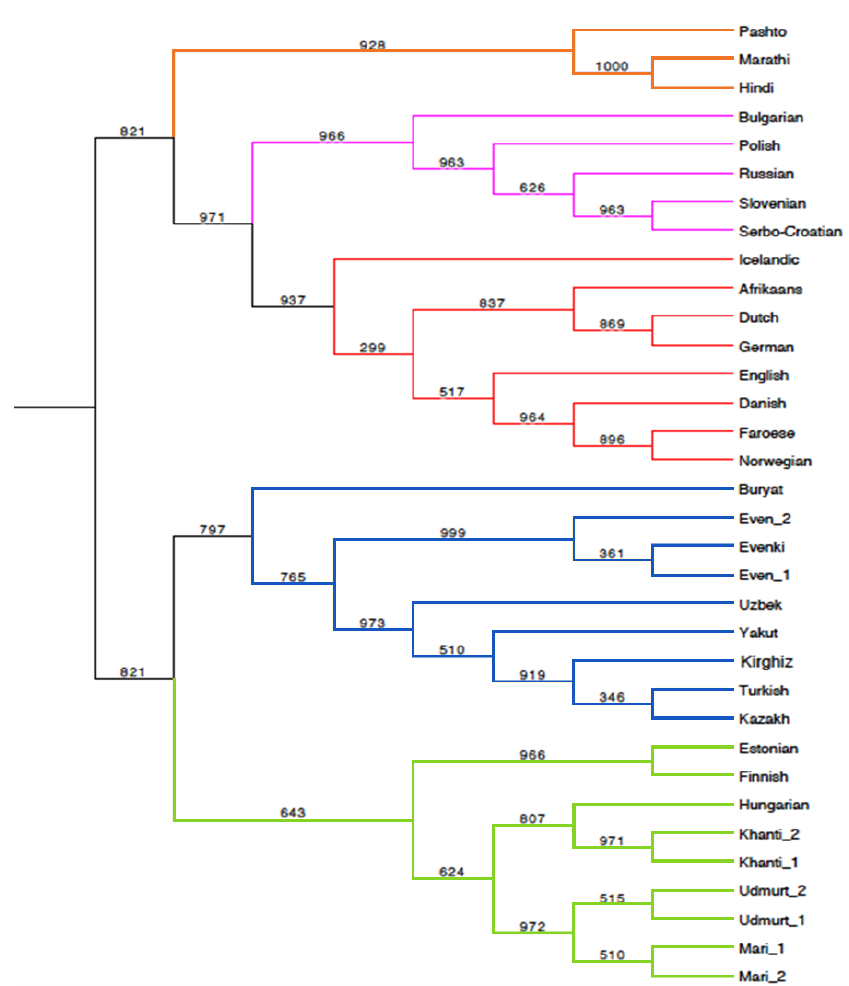
Figure 1. Principal Coordinate Analysis (PCoA) from the syntactic distances in 34 Eurasian populations. Language groups coded as follow: Finno-Ugric ( green ), Altaic ( blue ), Indo-European ( red ).